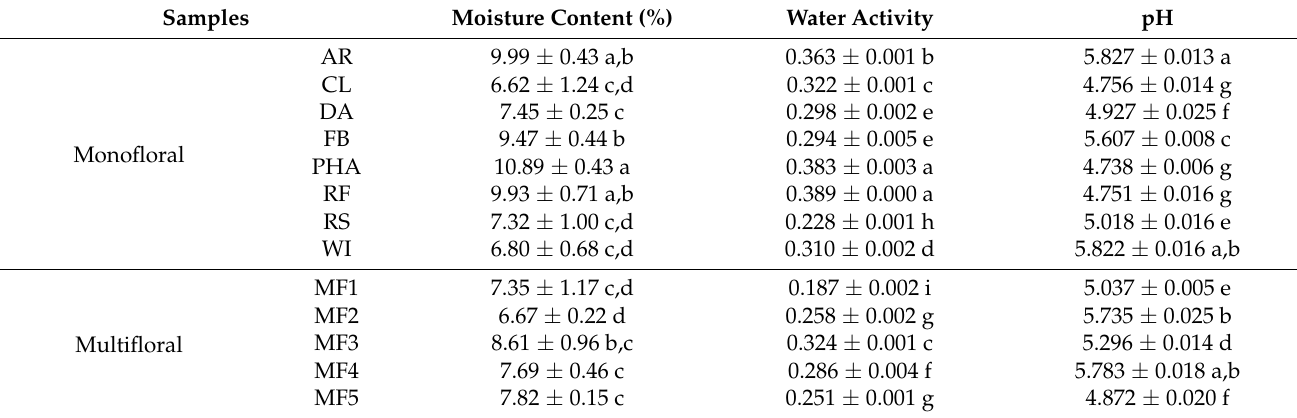
Table 1. Moisture content, water activity, and pH of honey bee-collected monofloral and multiflo- ral